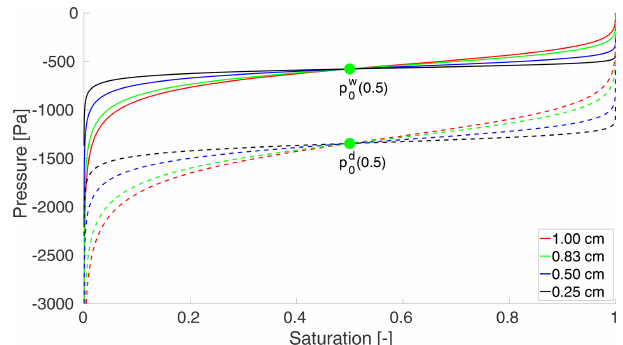
Figure 1. The scaling of the retention curve for 20 / 30 sand. The solid lines denote the main wetting branches, and the dashed lines denote the main draining branches for the respective value of (cid:49)x . The green curve represents the reference sample for (cid:49)x 0 = 10 cm 12 ≈ 0 . 83cm. As (cid:49)x → 0 , the retention curve becomes more flat, but the distance between the main wetting and draining branches re- mains the same. The main wetting and draining branches rotate ( 0 . 5 ) and p d ( 0 . 5 ) , around fixed values p w 0 0